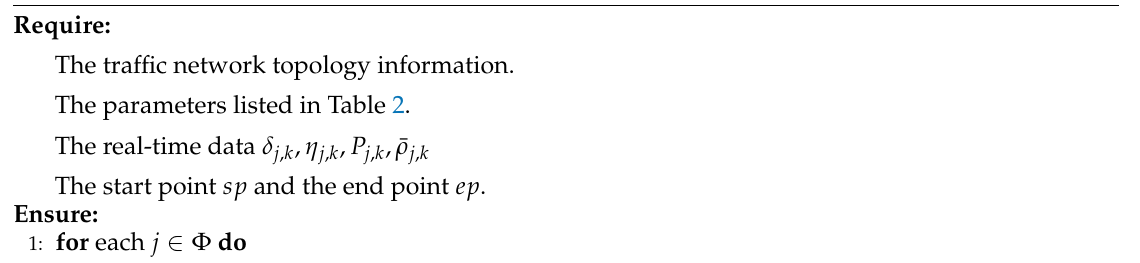
Algorithm 1 Optimal Path Planning Algorithm at slot k .